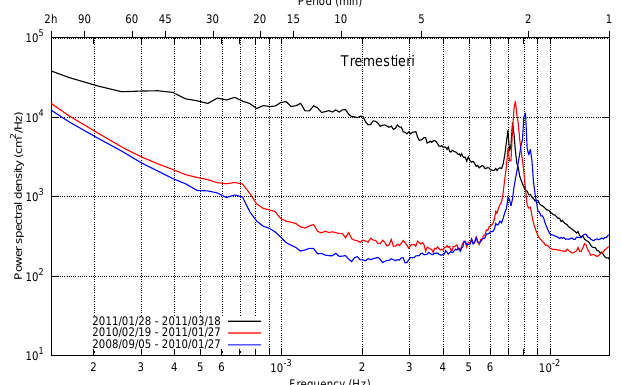
Fig. 3. Average power spectral density (PSD) for the three different homogeneous periods for background sea level identified for the station of